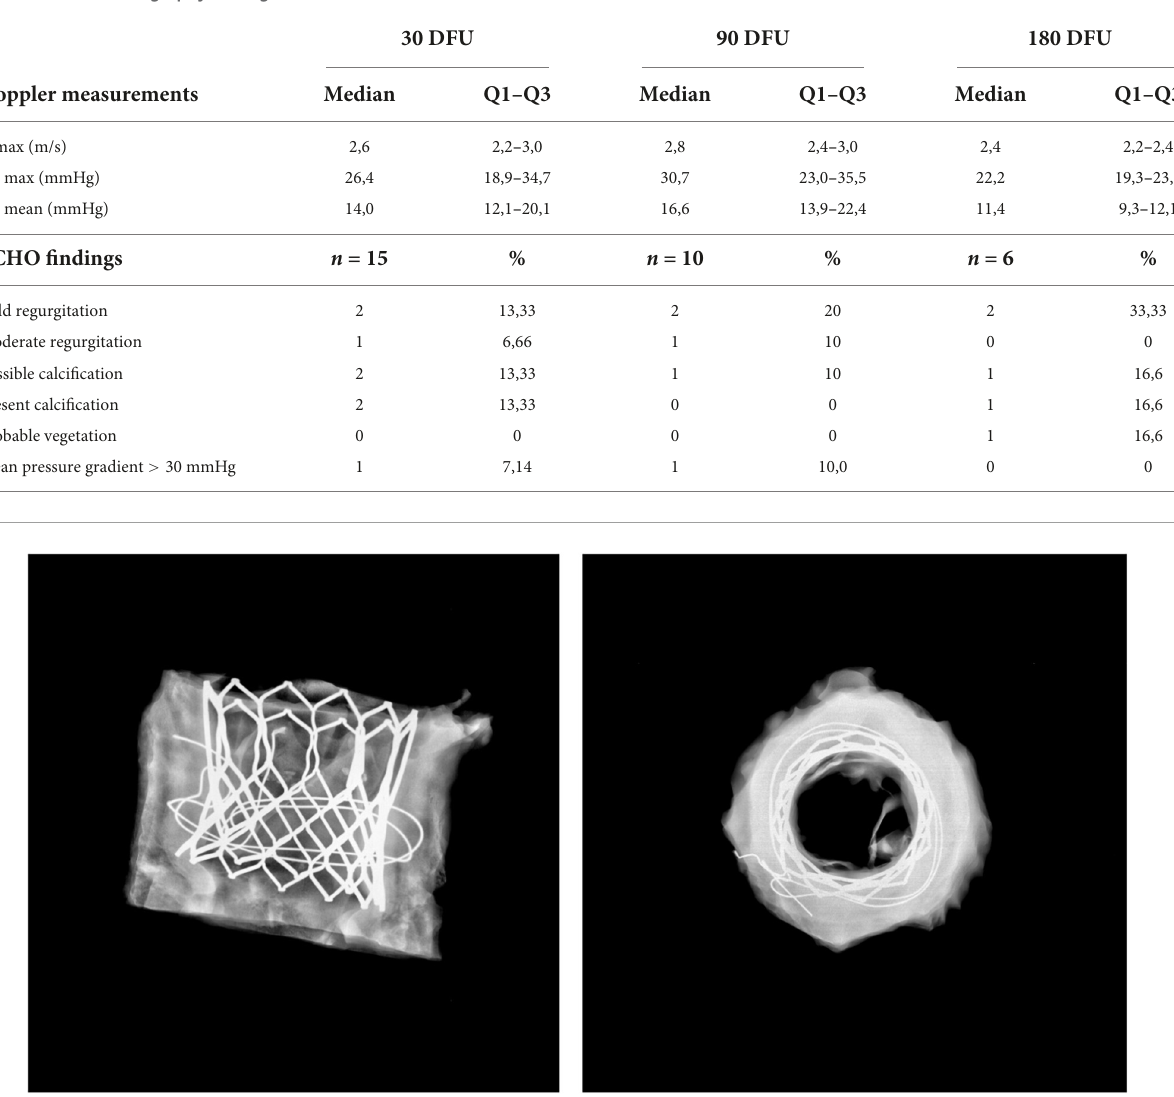
TABLE 2 Echocardiography findings.